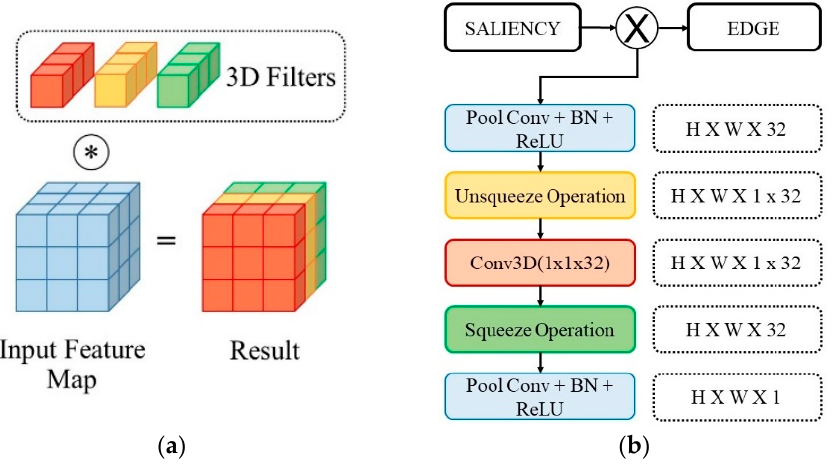
Figure 4. Details of the transition module ( a ) 3D CNN channel analyzer. ( b ) Final architecture of the transition module.